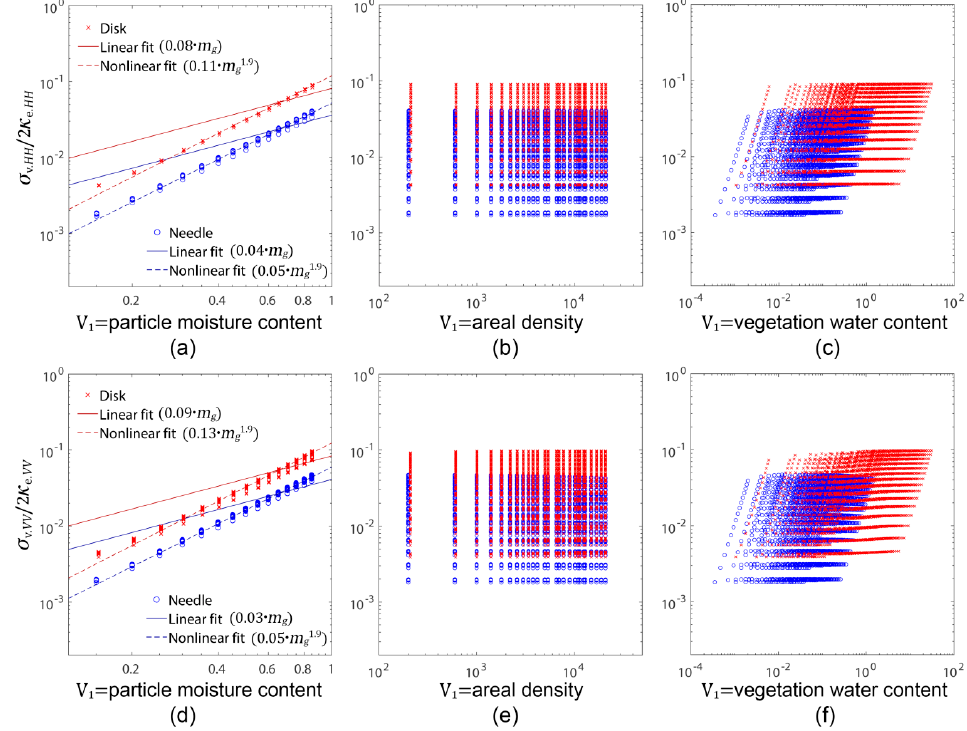
Figure 5. Variations of σ v , pq /2 κ e , pq in relation to the vegetation descriptors (left: particle moisture content (g/g); middle: the areal density (m − 2 ); right: the vegetation water content (kg/m 2 )) for ( a )–( c ) needle shaped and ( d )–( f ) disk shaped particles.